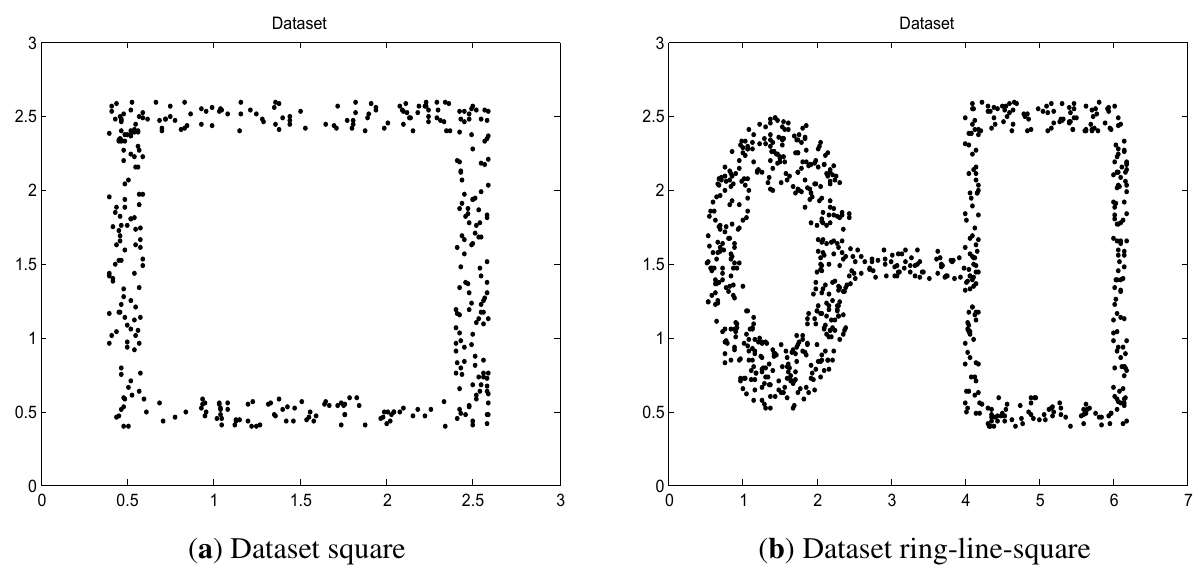
Figure 4. Synthetic dataset. ( a ) Square; ( b )